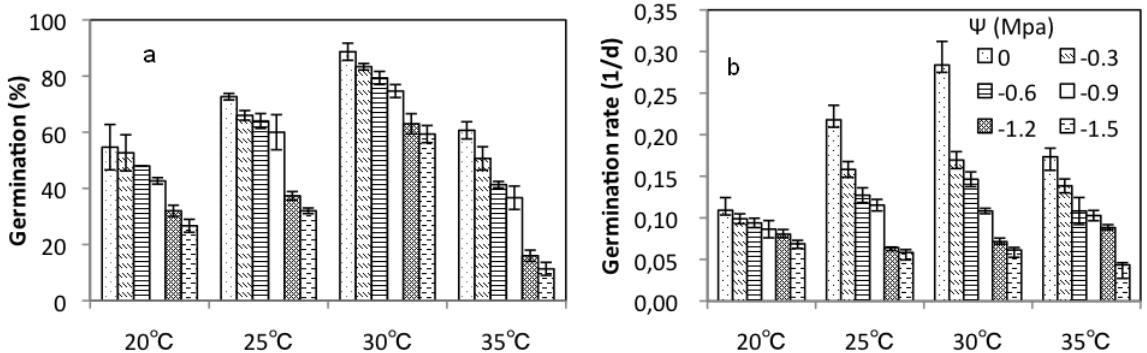
Fig. 1: Effect of temperature on the final germination (a) and germination rate (b) for A. venetum seeds incubated at various water potentials (Ψ) (0–